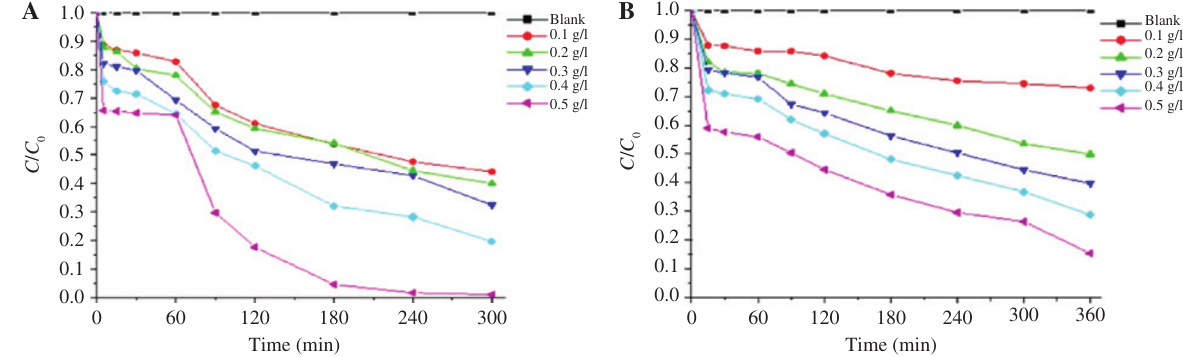
Figure 8: Effect of photocatalyst on the decolorization of (A) reactive black 5 and (B) methylene blue